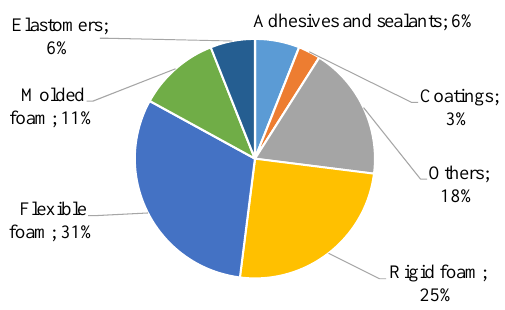
Figure 1. Global consumption of polyurethane (PU) in 2016 .